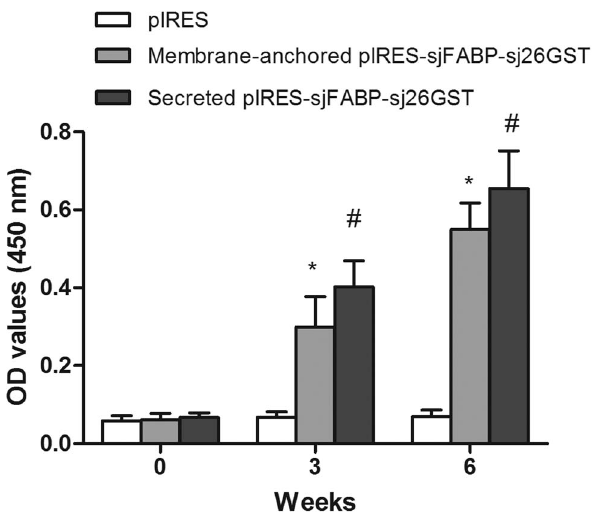
Figure 4. Analysis of the serological immune response to the vaccine. Total IgG antibody responses in mice injected with secreted pIRES-sjFABP-sj26GST, membrane-anchored pIRES-sjFABP-sj26GST, and pIRES as control. Absorbance values (450 nm) are shown as mean 6 SD of 10 mice in each group. Results are statistically significant (P , 0.05) when compared to the pIRES group: *; from the membrane-anchored group: # .